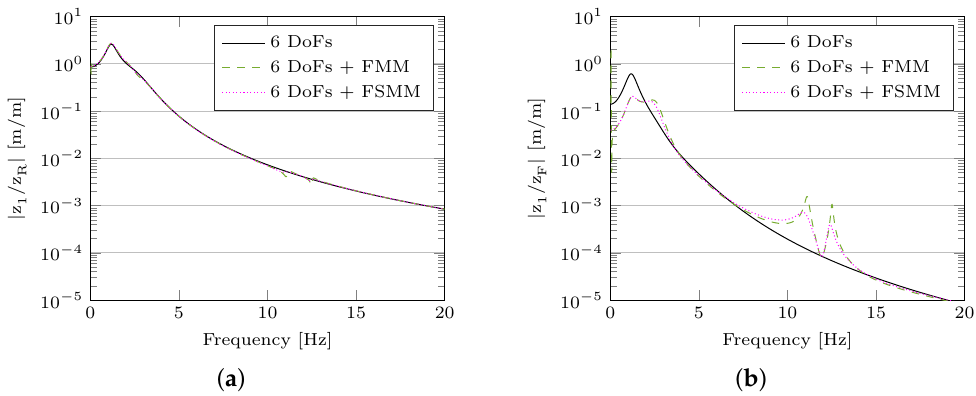
Figure 12. Transmissibility between the wheels of the 6-DoFs tractor and the operator’s seat z 1 with a front-mounted (FMM) or a front semi-mounted (FSMM) operating machine: ( a ) rear wheels z 1 / z R ; ( b ) front wheels z 1 / z F